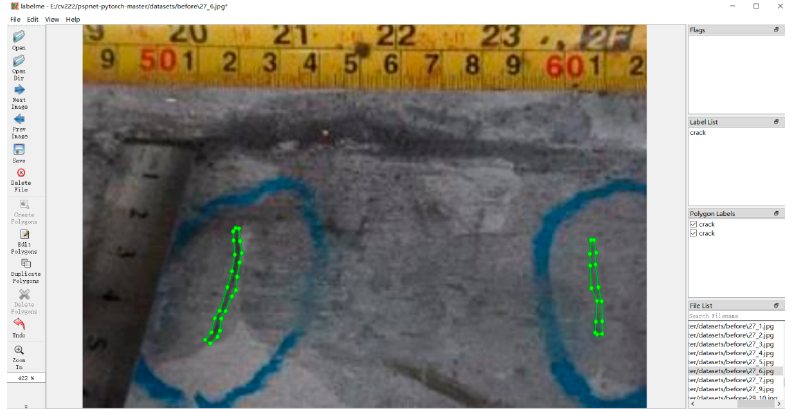
Figure 9. FPSO datasets.